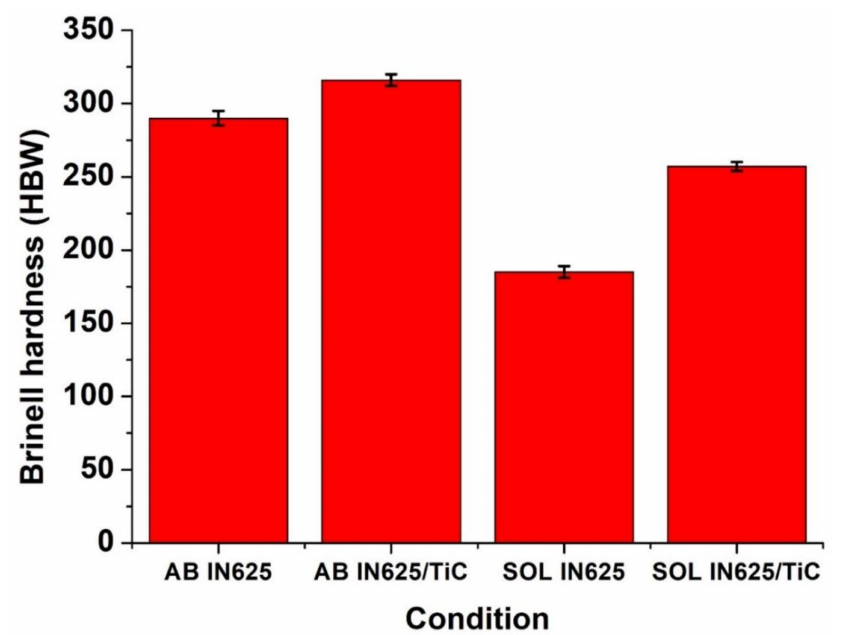
Figure 9. Hardness evolution of the AB and SOL IN625 and IN625/TiC